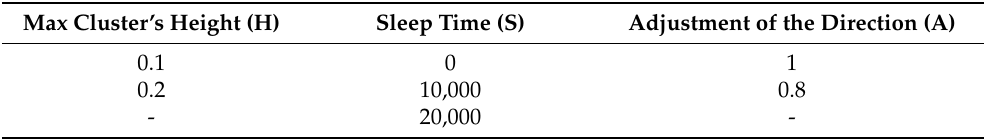
Table 3. Investigated settings for the parameters of Blossom.